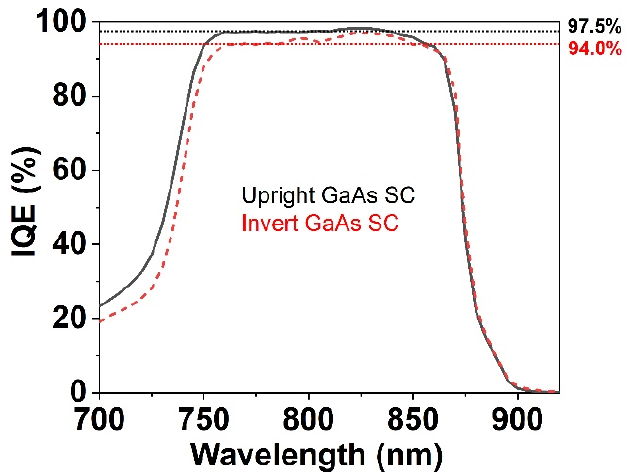
Figure 7. IQE spectra of fabricated GaAs solar cells grown in upright structure (black solid line) and inverted structure (red dashed line). Both GaAs solar cells have AlGaAs absorbing layer to simulate the GaAs sub-cell in multi-junction solar cells. Inverted GaAs solar cell presents decreased IQE compared with upright reference.